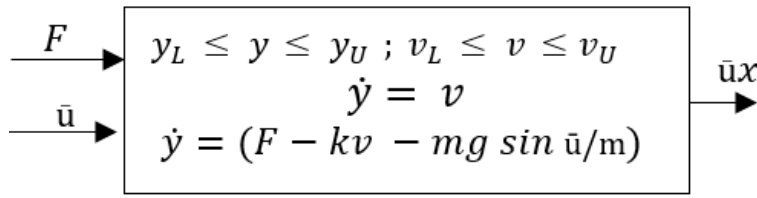
Figure 5. Continuous-Time model for platooning vehicle with variability.